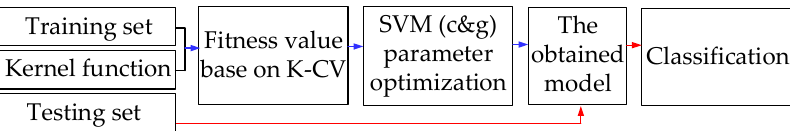
Figure 4. The PSO-SVM training model. K-CV: K-fold cross Figure 4. The PSO ‐ SVM training model. K ‐ CV: K ‐ fold cross validation.